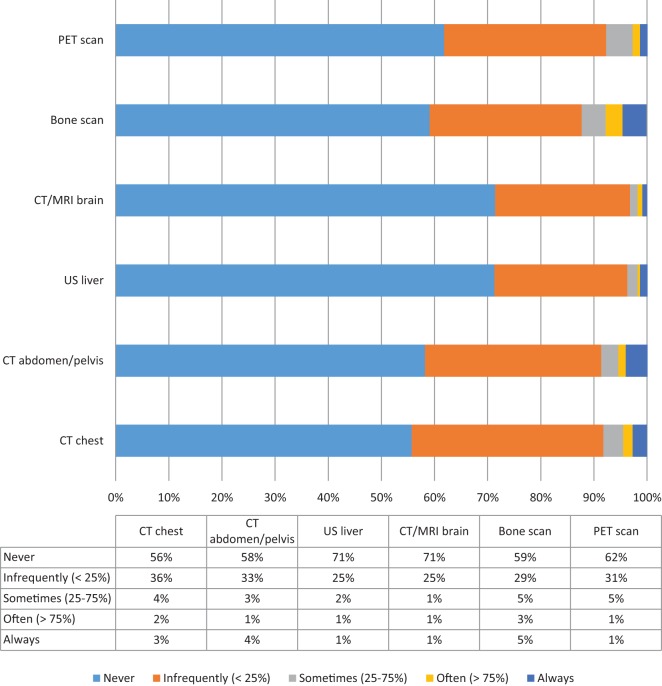
Distribution of tests typically used for the evaluation of distant metastatic disease. Proportion of respondents reporting their likelihood of ordering CT scan chest, CT scan abdomen/pelvis, Ultrasound liver, CT/MRI brain, Bone scan, PET scan.